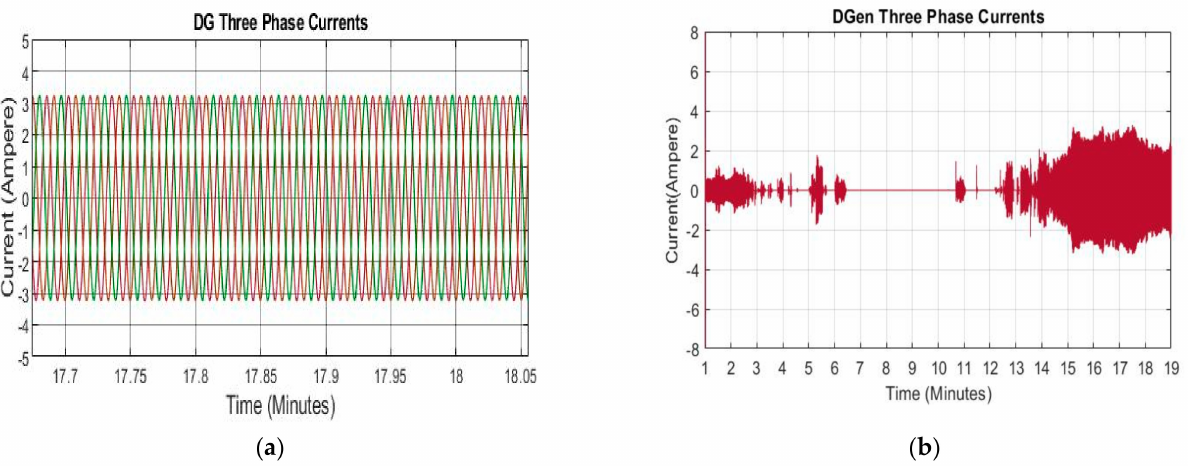
Figure 14. ( a ) Zoom in view of three phase currents. ( b ) Three phase currents of Diesel